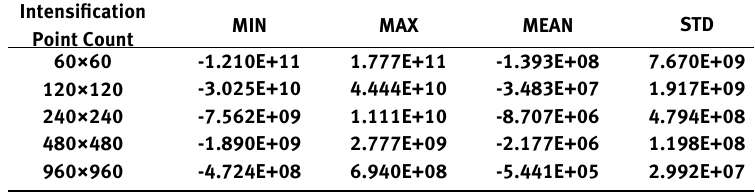
Table 1. Result of Original Method /Unit: E (Eötvös=10 −9 s −2 )